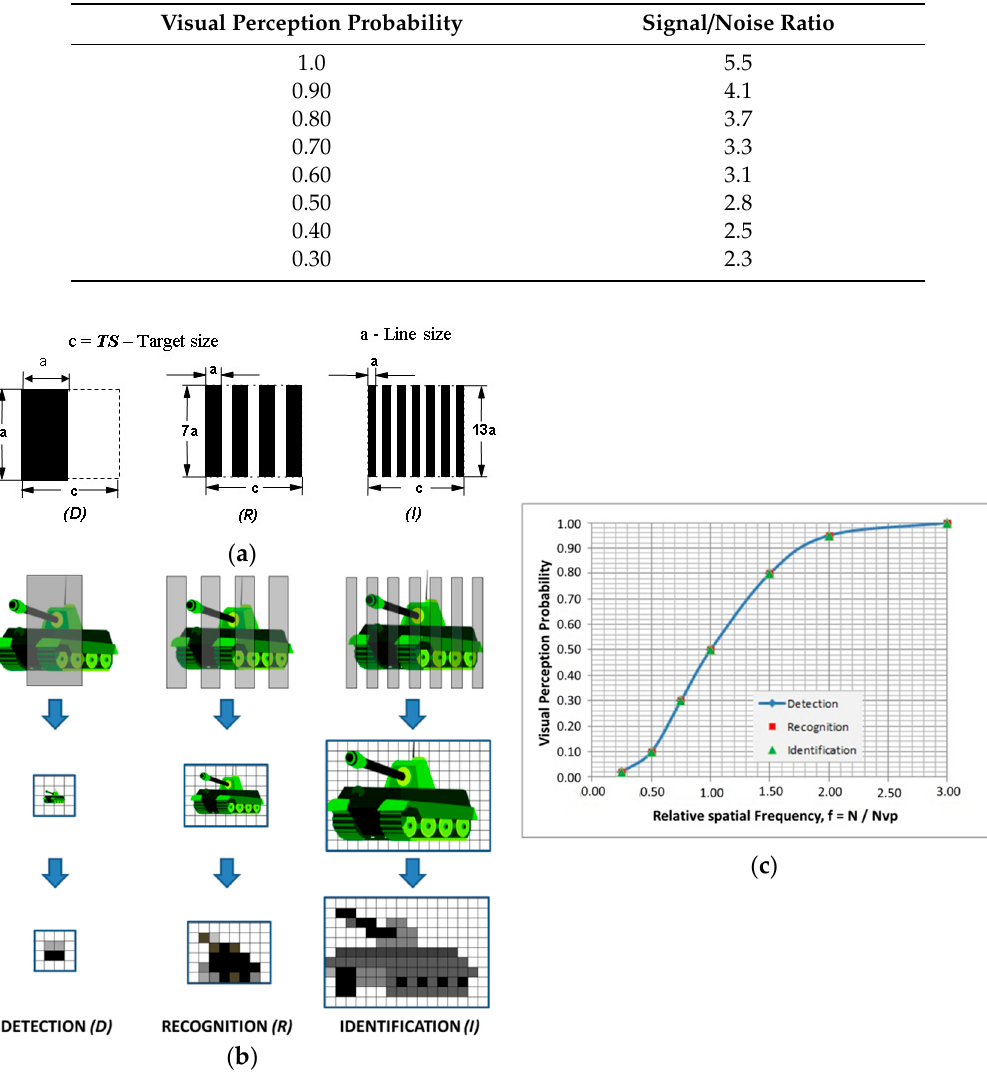
Table 4. Visual data perception probability and required minimal signal to noise value.